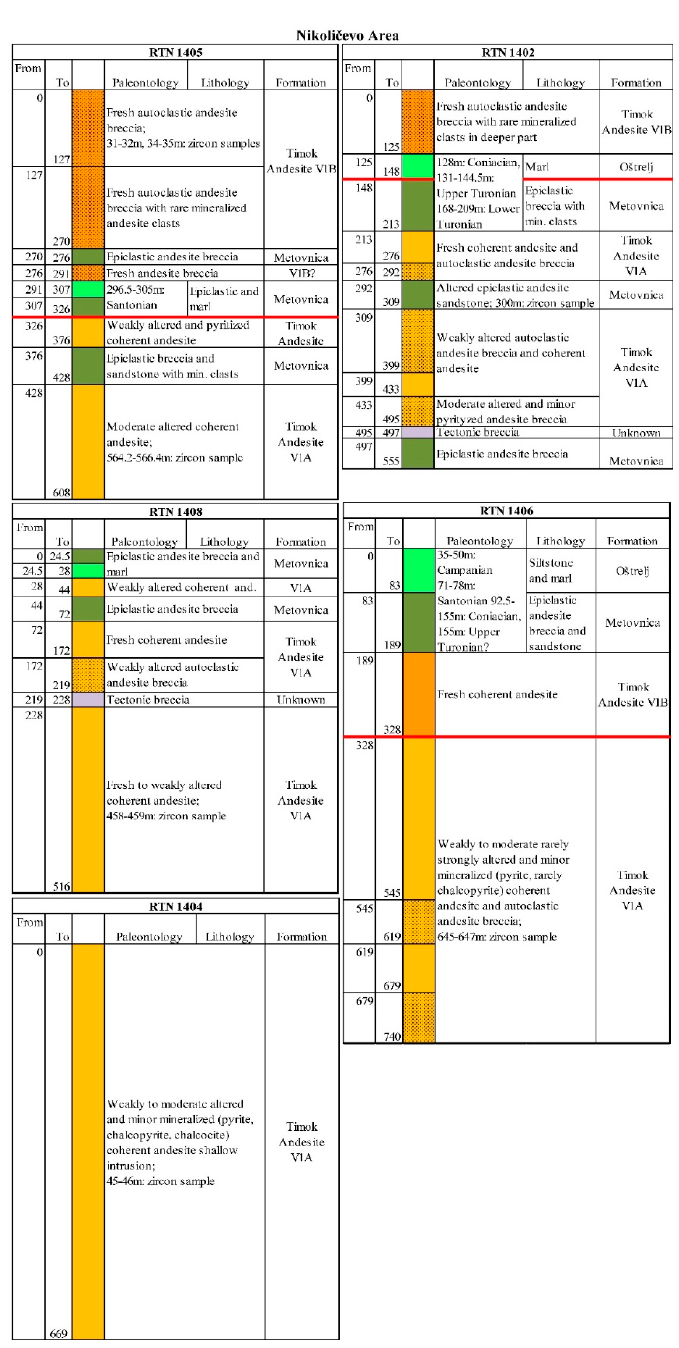
Figure 3. Stratigraphic logs of the drill holes from the Nikoli č evo area. The hatched pattern indicates andesite breccia, whereas the red line marks the boundary between the two andesite subgroups.